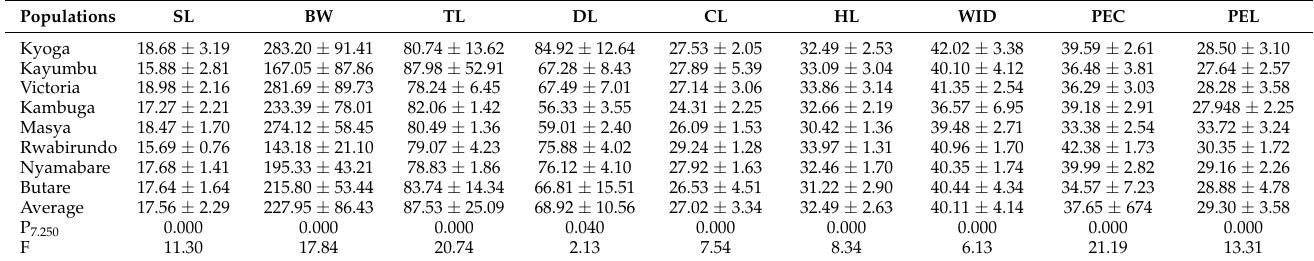
Table 1. Mean ± SD for the different morphometric characters of O. niloticus population (significantly different ( p < 0.05) (SL = Standard Length, BW = Body weight, TL = Total Length, DL = Dorsal fin Length, CL = Caudal fin Length, HL = Head Length, WID = Body Width, PEC = Pectoral fin Length, PEL = Pelvic fin Length).